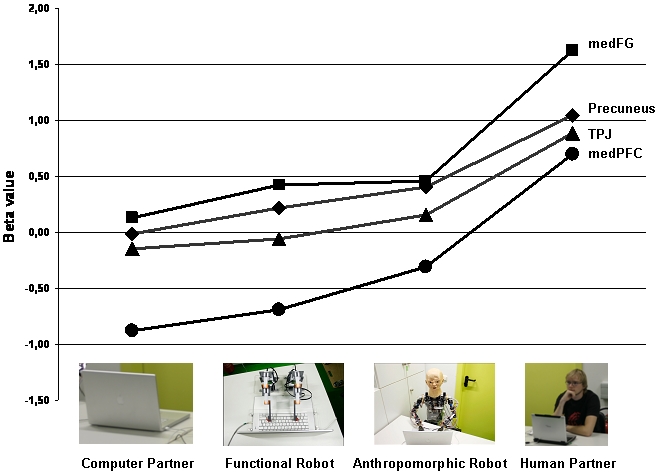
Averaged parameter estimates (beta values) for each condition derived from the individual local maxima activations (TPJ = temporo-parietal junction; medFG = medial frontal gyrus; medPFG = medial prefrontal gyrus; Precuneus).